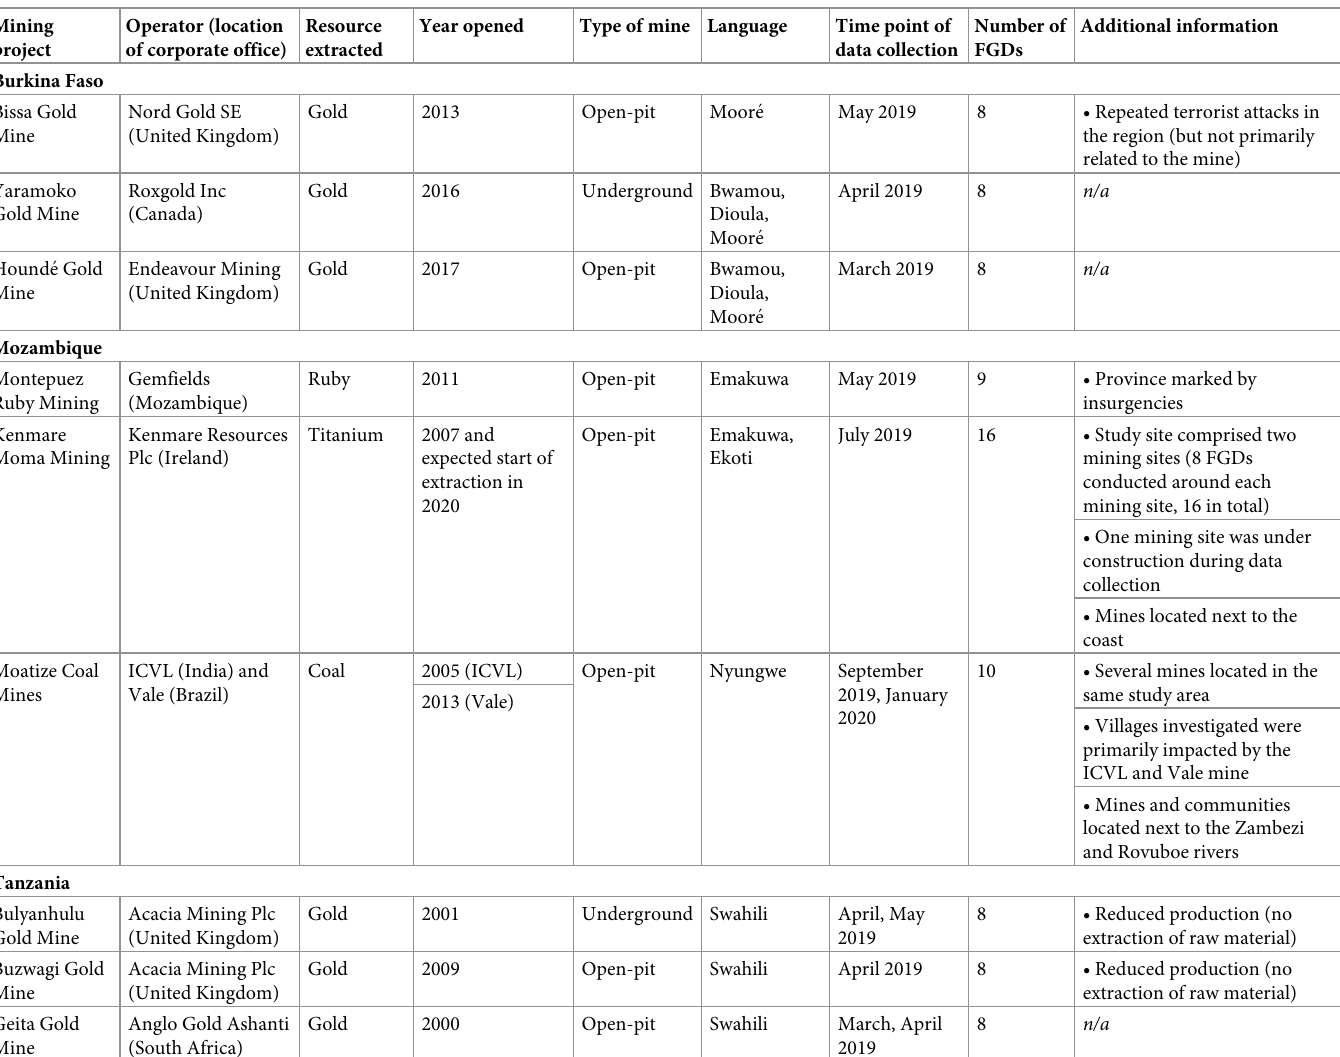
Table 1. Characteristics of study sites.